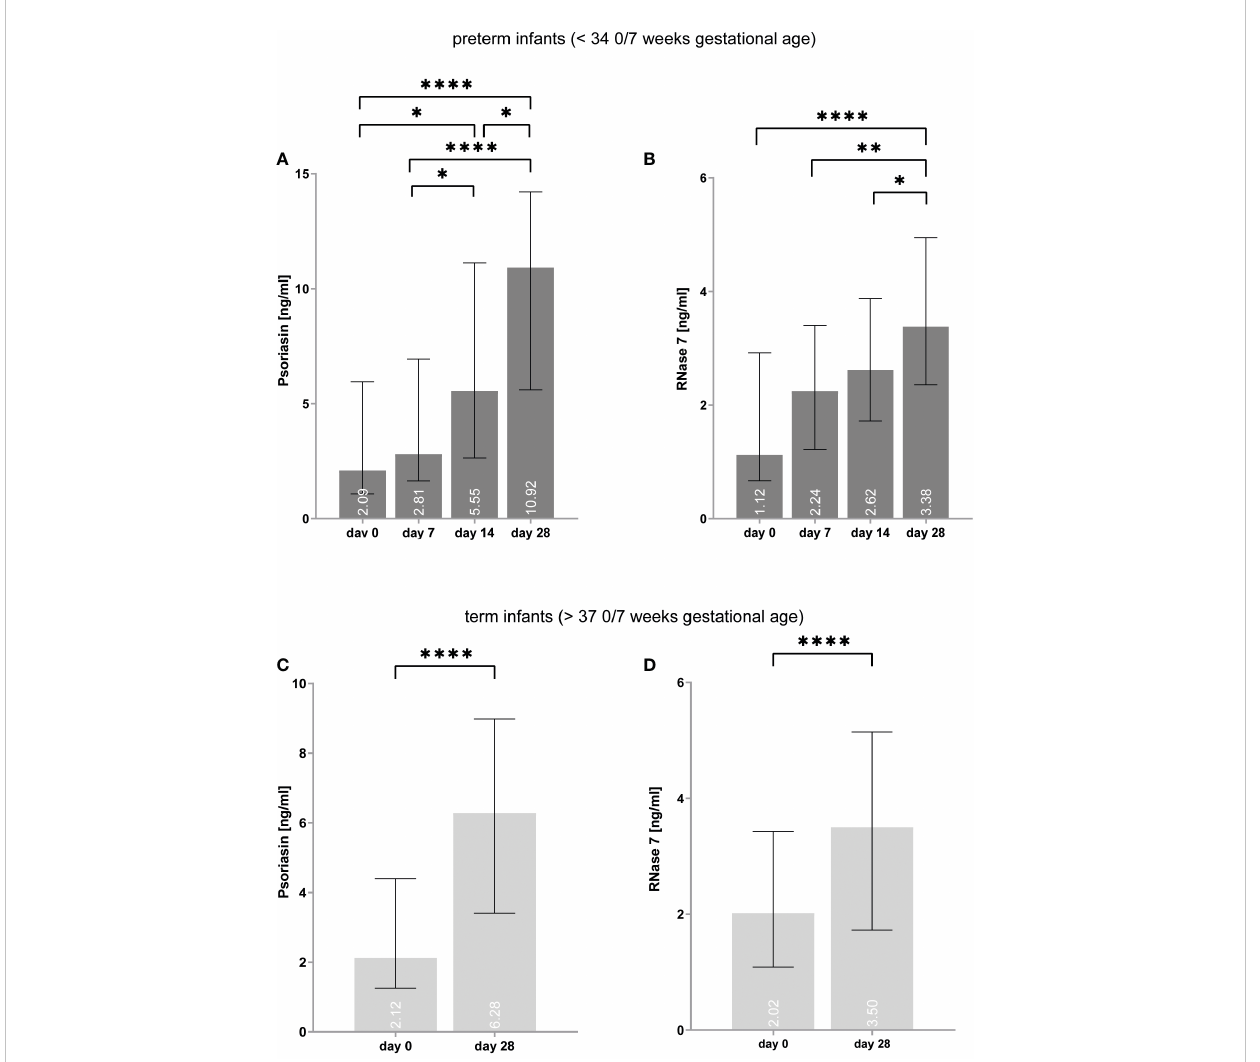
FIGURE 2 (A – D) Expression of psoriasin and RNase 7 in premature (A, B) and term (C, D) infants increases over time. *p < 0.05, **p < 0.01, and ****p < 0.0001 (ordinary one-way ANOVA with Holm – Sidak ’ s multiple comparisons test for preterm infants, Wilcoxon signed-rank test for term infants). Medians are given for each day in white